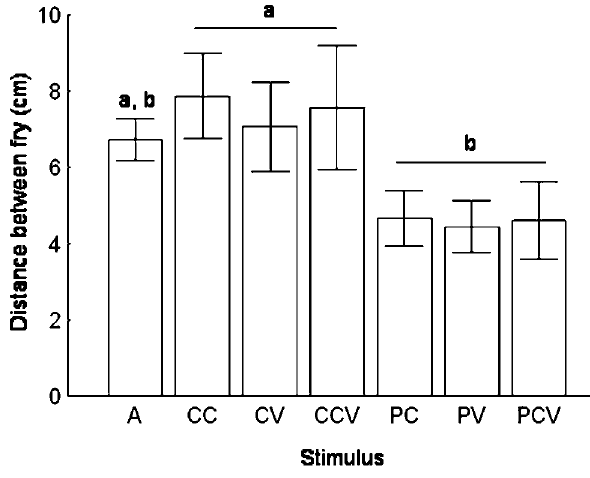
Figure 2. Mean Distance Between Fry During Trials This figure shows that fry shoal more tightly when presented with predator chemical (PC), predator visual (PV), and simultaneous predator chemical and visual (PCV) stimuli, than when presented with conspecific chemical (CC), conspecific visual (CV), and conspecific chemical and visual (CCV) stimuli. The mean distance between fry during the acclimatization period (A) was intermediate between the mean inter- fry distances during conspecific and predator stimuli trials. Bars and whiskers represent the mean 6 SE. Means with different letters above them are significantly different ( p , 0.05).